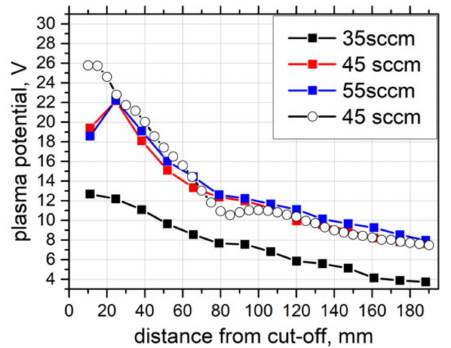
Figure 15. Profiles of plasma potential along the axis of the